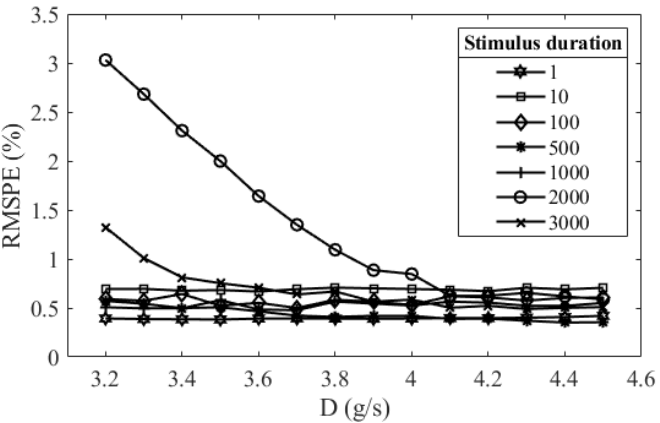
Figure 3. Relations between the root-mean-square percentage error (RMSPE) of model simulation results and the viscous constants when the stimulus durations were 1ms, 10 ms, 100 ms, 500 ms, 1 s, 2 s, and 3 s. Table 1. Initial value and boundary value of the parameter for model simulation and prediction.